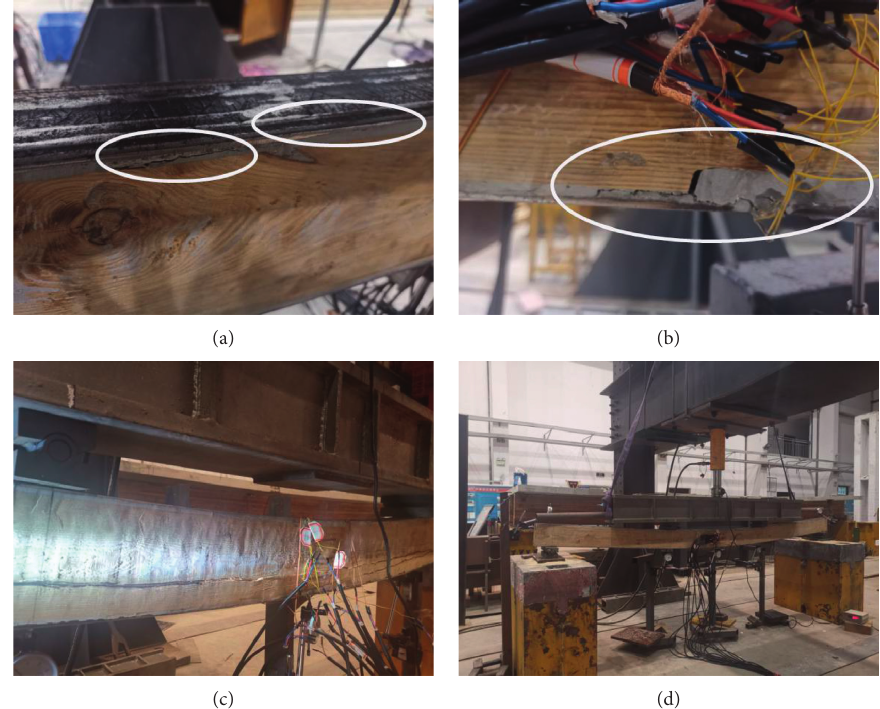
Figure 8: Failure mode of L3 specimen. (a) Beginning of degumming. (b) Slight cracking in the middle. (c) Tension cracks in tension area. (d) Bending